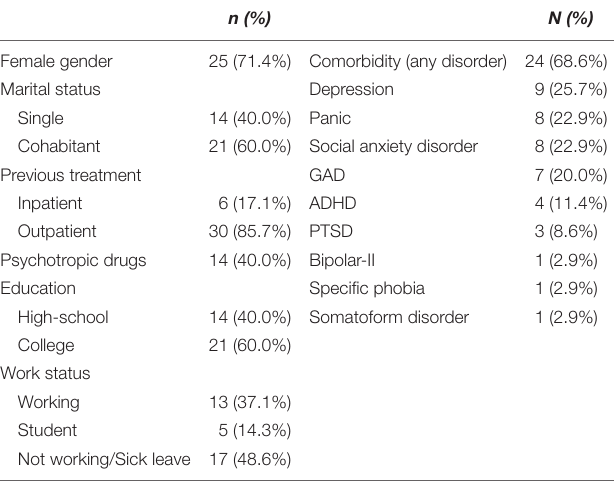
TABLE 1 | Demographics and diagnostic characteristics of the sample ( N =